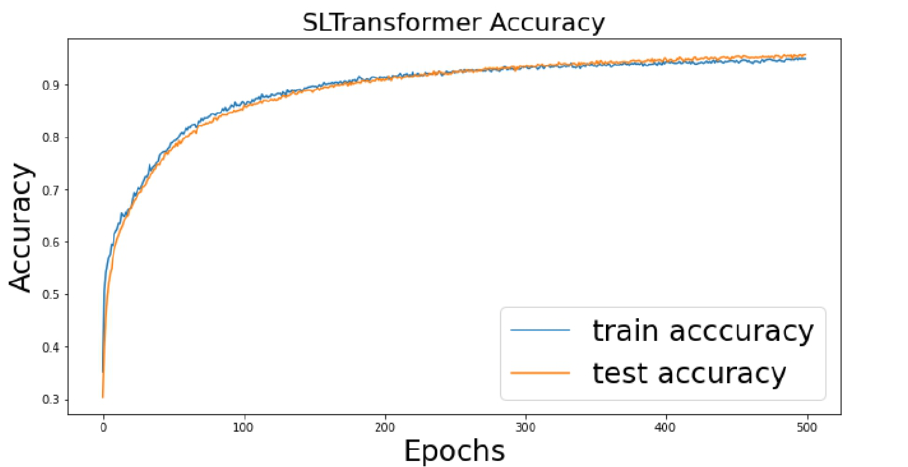
Figure 15. This accuracy graph of Sl transformer. The x -axis describes epochs and the y -axis de- scribes accuracy.